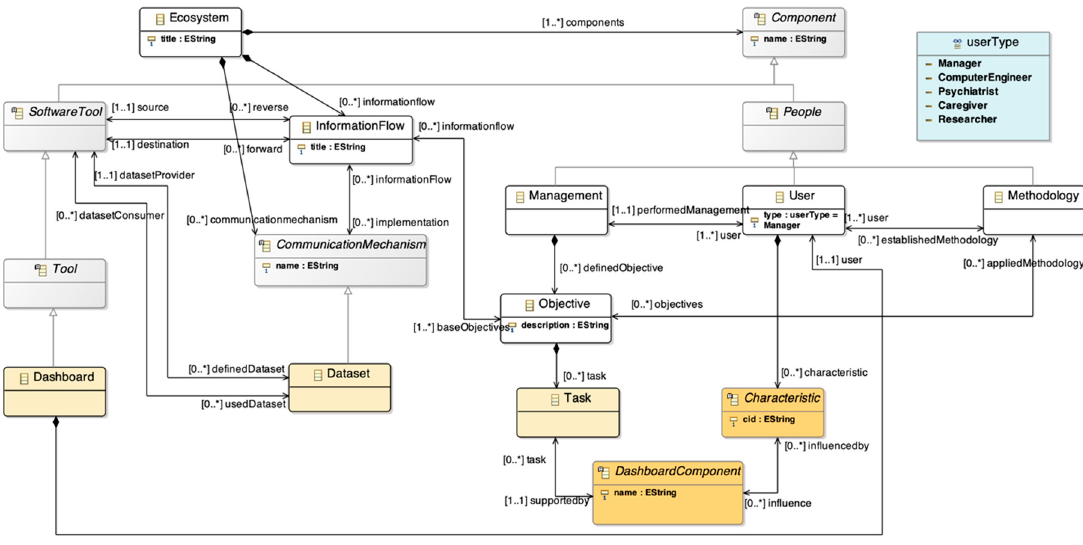
Figure 7. Holistic meta-model: the integration of the learning ecosystem meta-model with the dashboard meta-model.